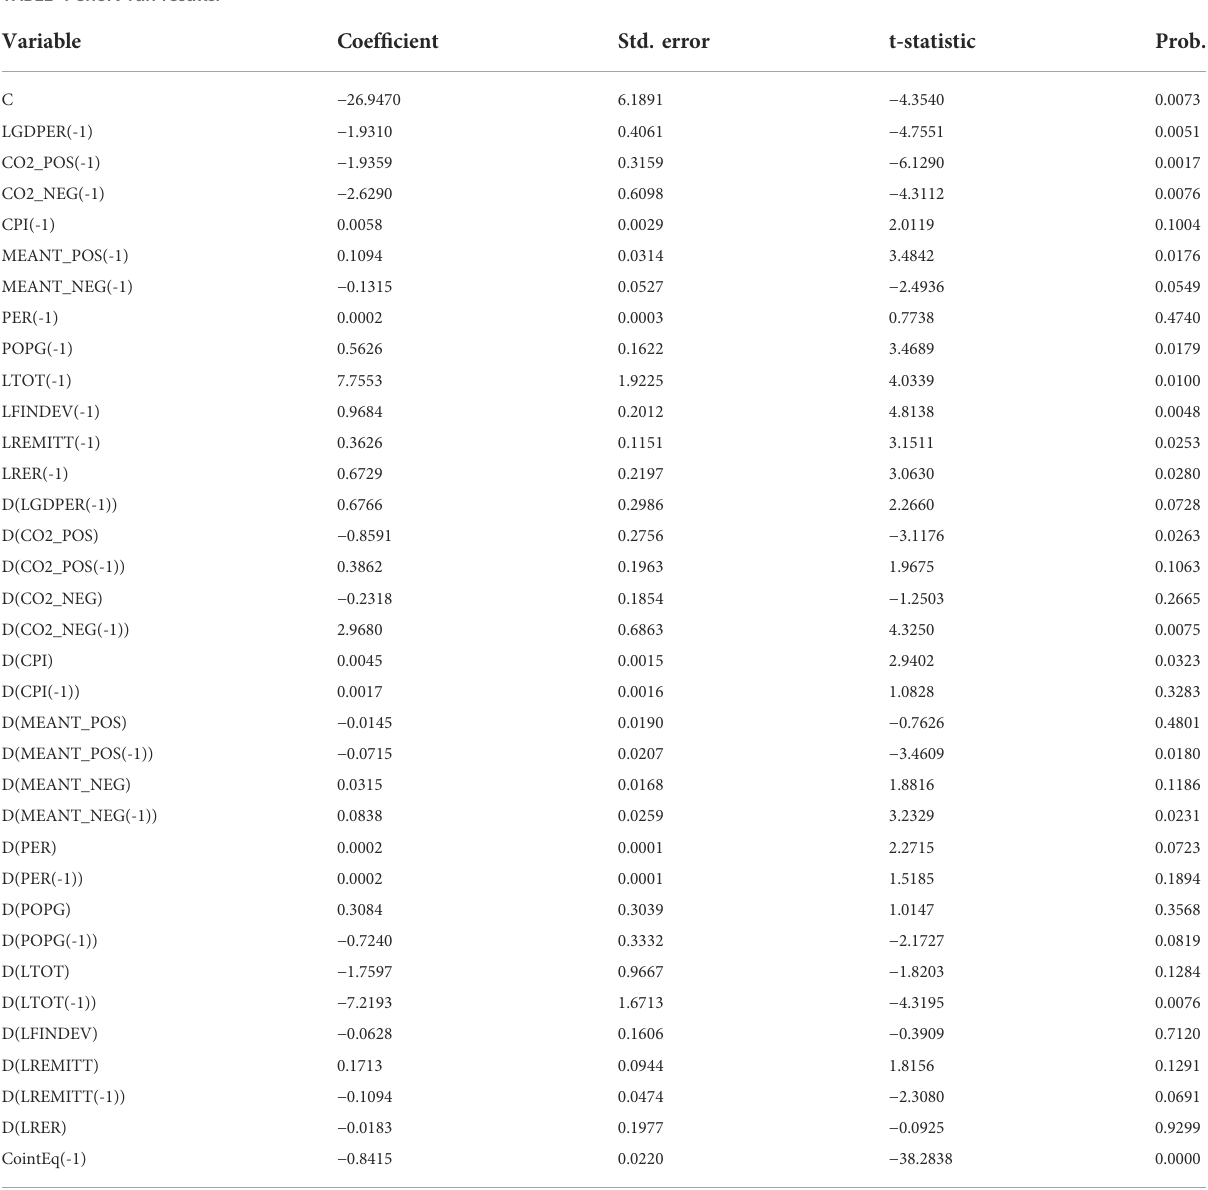
TABLE 4 Short-run